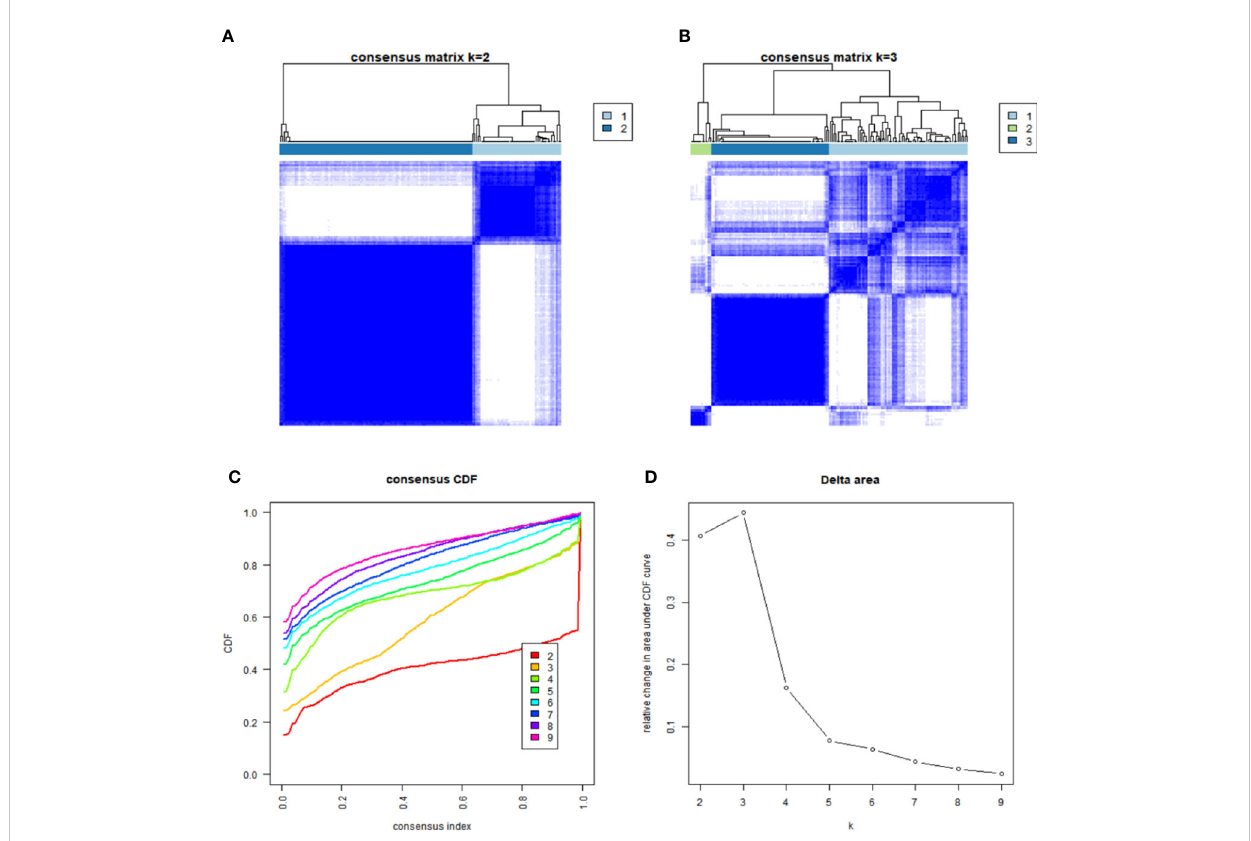
FIGURE 2 Identi fi cation of GBM ferroptosis-related subgroups. (A, B) Heatmap of the samples under the condition of consensus k = 2 (A) and k = 3 (B) . (C) Consensus clustering cumulative distribution function (CDF) for k = 2 to 9. (D) Relative change in the area under the CDF curve for k = 2 to